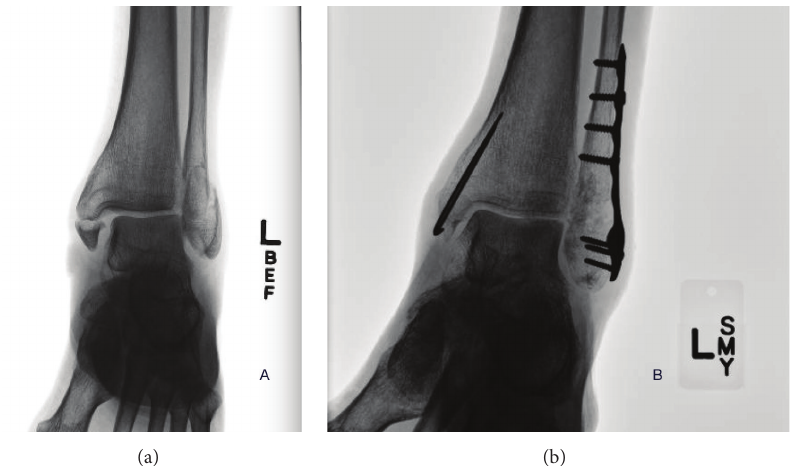
Figure 2: (a) demonstrates a preoperative bimalleolar fracture with a small medial malleolus contribution. (b) shows the mortise view post- operative fixation with the KTB.